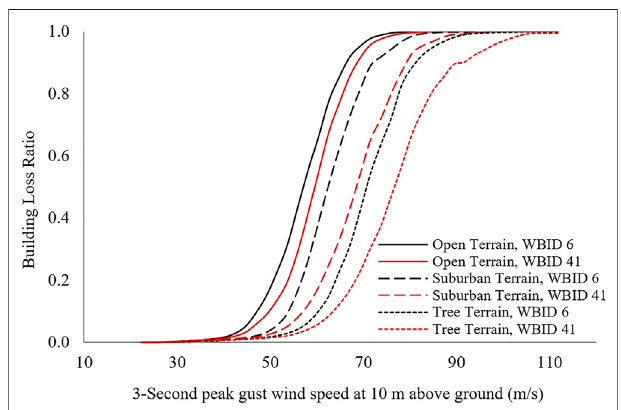
FIGURE 2 | Building-loss functions, expressed as the ratio of repair or replacement cost to building value, for multiple terrain classi fi cations for an